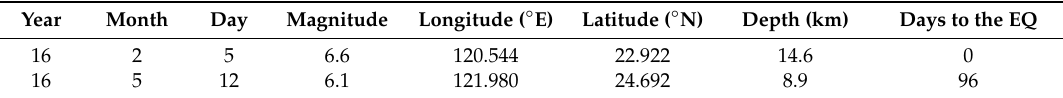
Figure 5. Variations of seismic velocity data in the vertical component filtered using a bandpass filter of 8 × 10 − 5 –2 × 10 − 4 Hz from 200 days before to 150 days after the Meinong earthquake. Red lines indicate occurrence times of two M > 6 earthquakes listed in Table 1. Similar variations can be seen from most stations in Taiwan. Notably, gaps were found in data from the B020 and B530 stations and are ignored in this study. Table 1. Earthquake information in Taiwan from 200 days before and 150 days after the Meinong earthquake. Earthquakes with magnitude > 6.0 are listed.